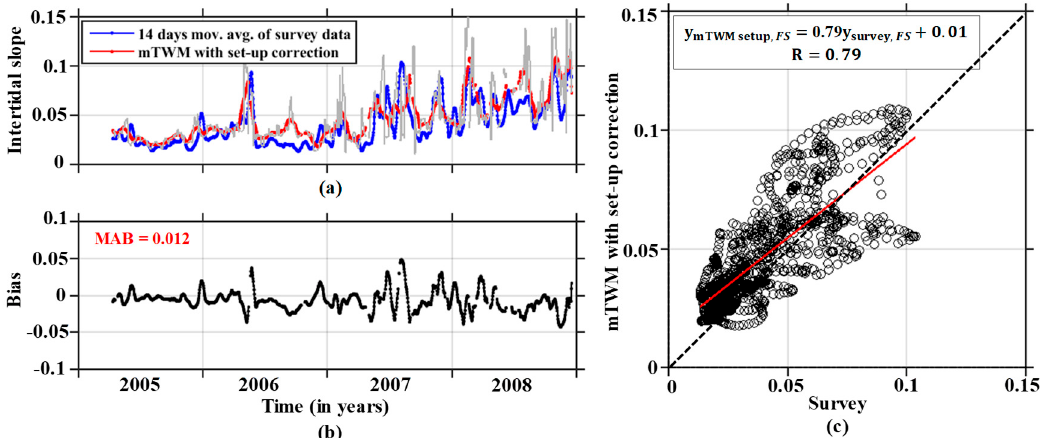
Figure 19. ( a ) The temporal variations in intertidal foreshore slope (FS) estimated from the survey and mTWM-derived results with corrected wave set-up (at x = − 49 m), where off-white and red lines indicate the mTWM-derived intertidal foreshore slope and its 14-day moving average, respectively. ( b ) The bias between the survey data and mTWM-derived results with corrected wave set-up. ( c ) The scatter plot of the survey data vs. mTWM derived results with corrected wave set-up. The red line represents the linear fitting line.